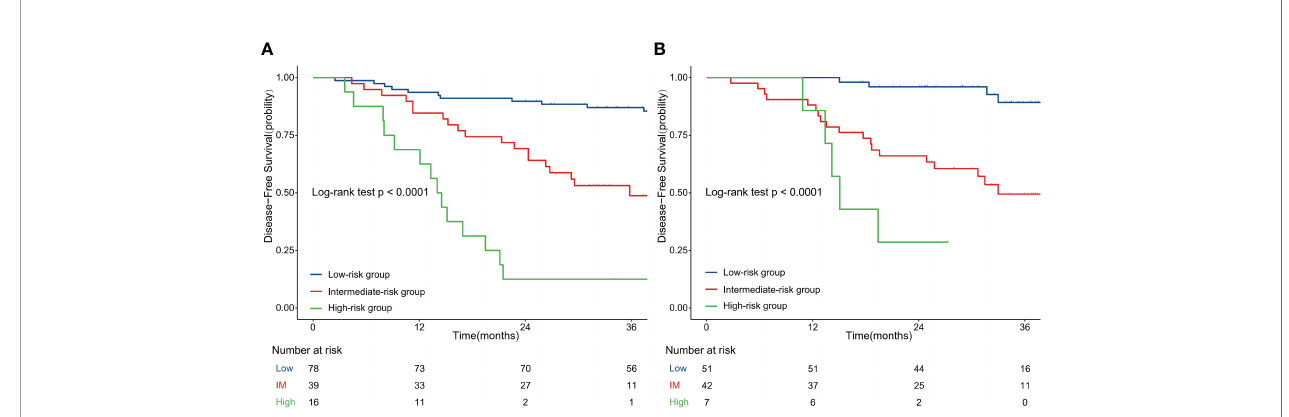
FIGURE 3 | Disease-free survival curves according to patient risk strati fi cation: Survival curves strati fi ed by the nomogram model in the training cohort (A) and validation cohort (B) ;